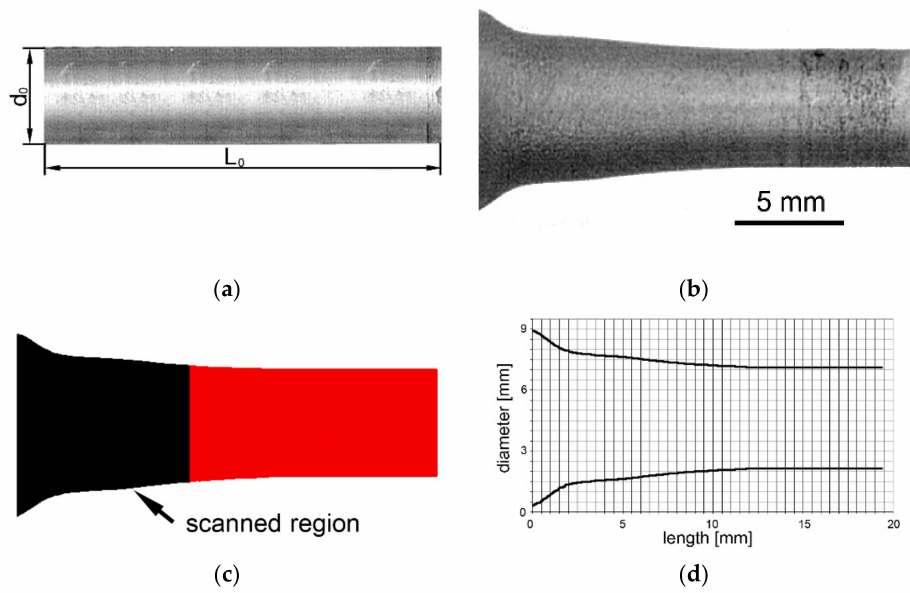
Figure 6. Testing specimen before TAT ( a ); tested specimen after TAT ( b ); acquired image of the surface of the tested specimen ( c ); final geometrical curve characterising tested specimen after TAT ( d